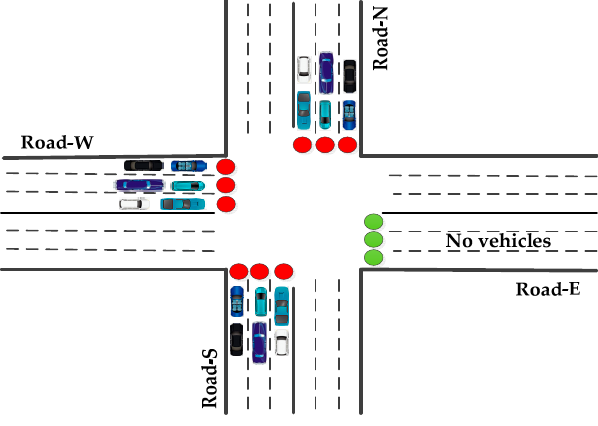
Figure 9. Empty lane with green light [50].